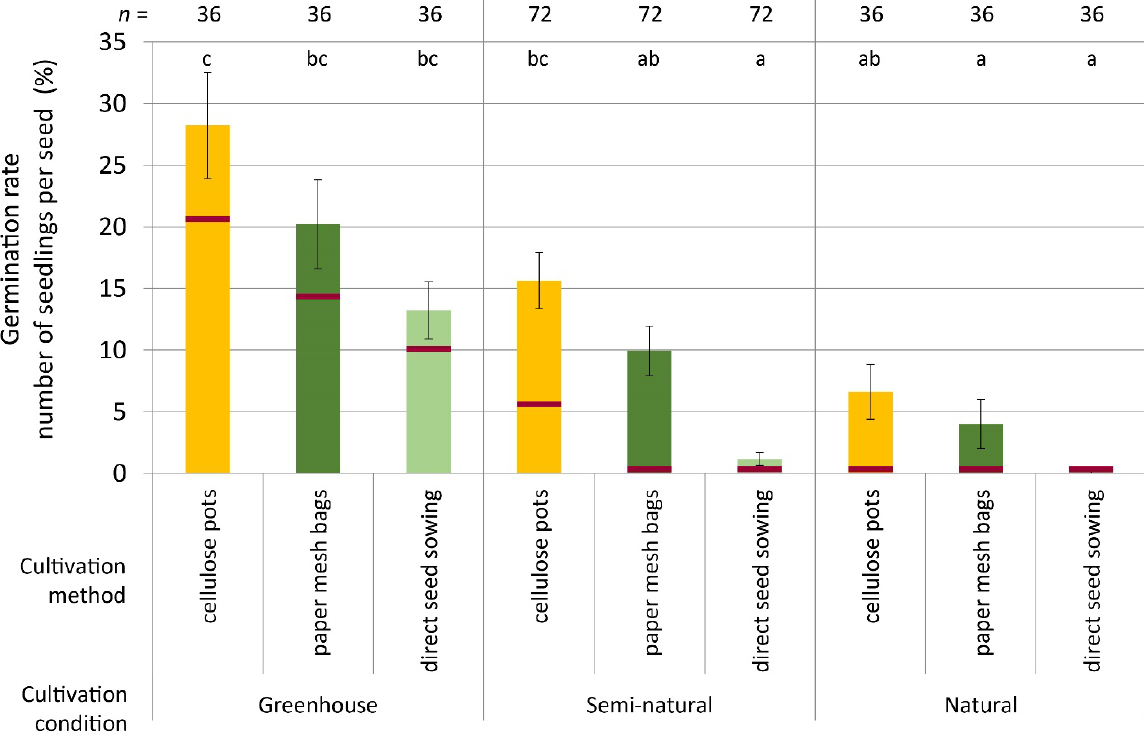
Figure 2. Germination rate of Drosera rotundifolia for the different cultivation conditions and methods. Vertical bars show the means, the whiskers the SE, the red lines the medians. Number of replicates is written above each bar. Values with different letters differ significantly ( P ≤ 0.05).